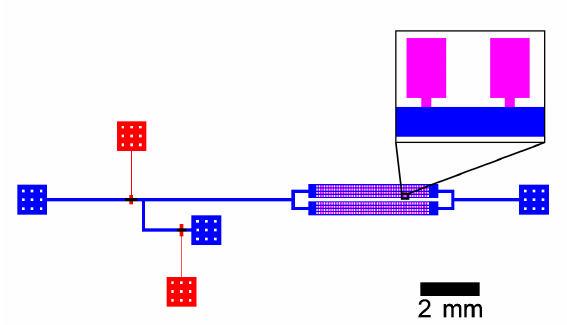
Figure 2. Schematic channel layout of the microfluidic chip with supply channels (blue), growth chambers (pink), and control channels (red). The magnification shows two adjacent